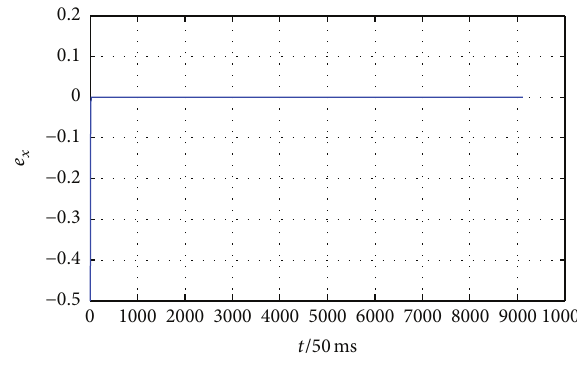
Figure 9: The curve 𝑒 𝑥 for multivariable feedback